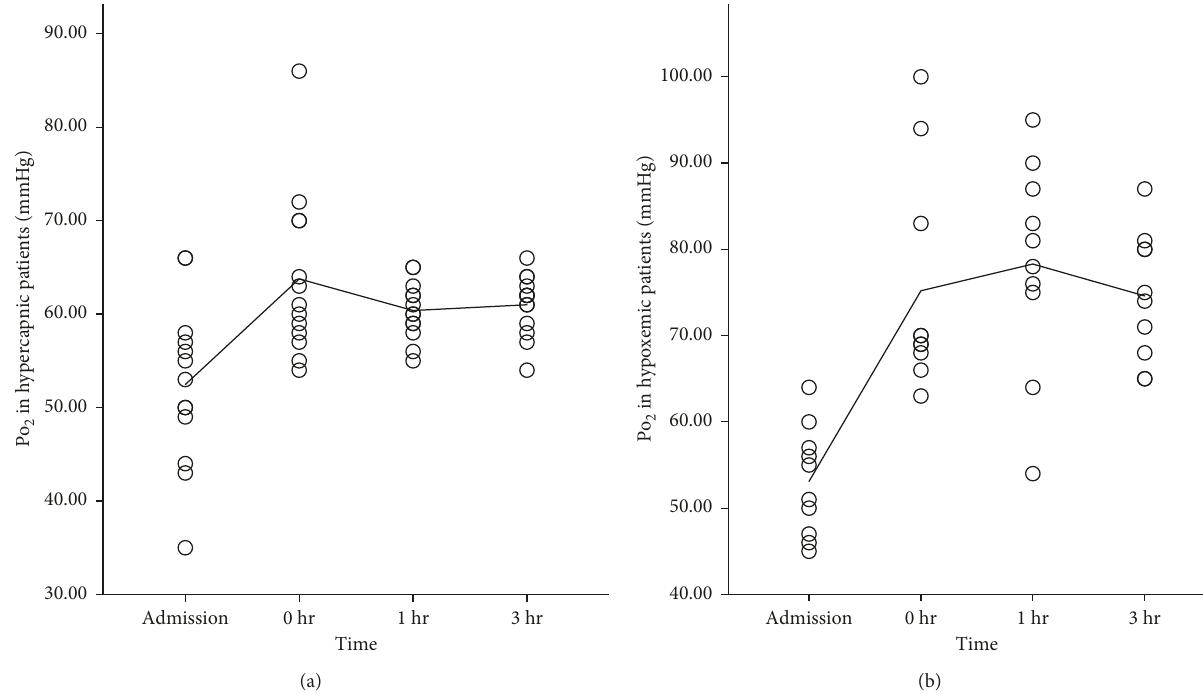
Figure 5: pH levels of hypercapnic and purely hypoxemic ARF patients at admission, just before the application of the device (0hr), 1 hour after the application of the device (1hr), and 3hours after the application of the device (3hr). The line corresponds to the mean value of each group.